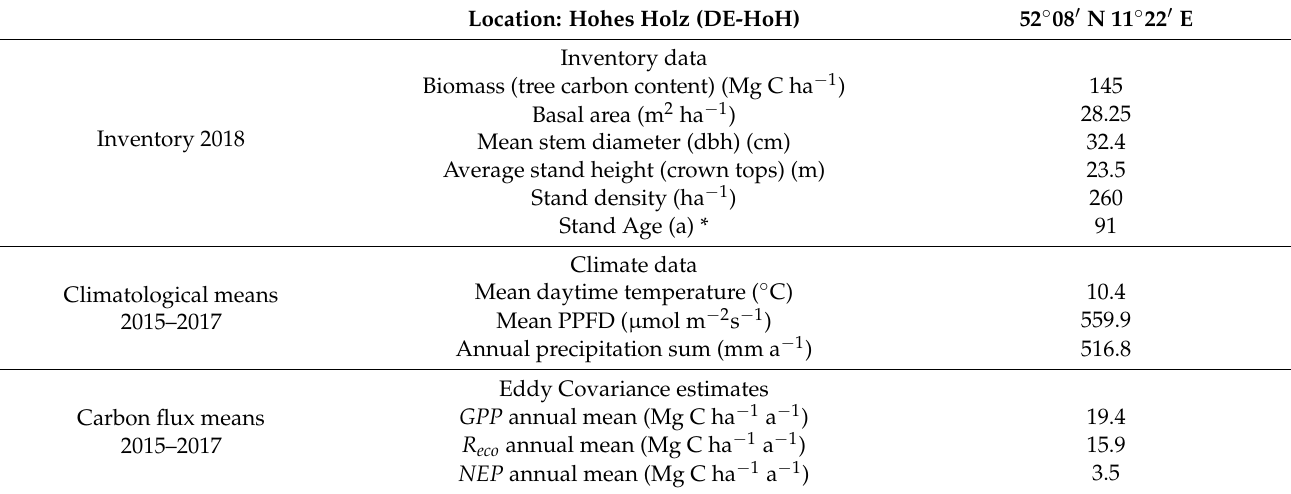
Table 1. General information about the study site Hohes Holz (DE-HoH) in Central Germany. Presented are forest inventory data from 2018 for the 1-ha intensive research area, climate data from 2015–2017 and carbon fluxes derived from EC measurements. Daytime was defined as the time when photosynthetic photon flux density (PPFD) > 20 µ mol m − 2 s − 1 (night time was excluded). Climatic mean values were calculated as averages over 30 min measurements per day for 2015–2017. Eddy covariance mean values are the annual mean value of the daily sum of 30 min measurements for the years 2015–2017. * stand age according to forest management